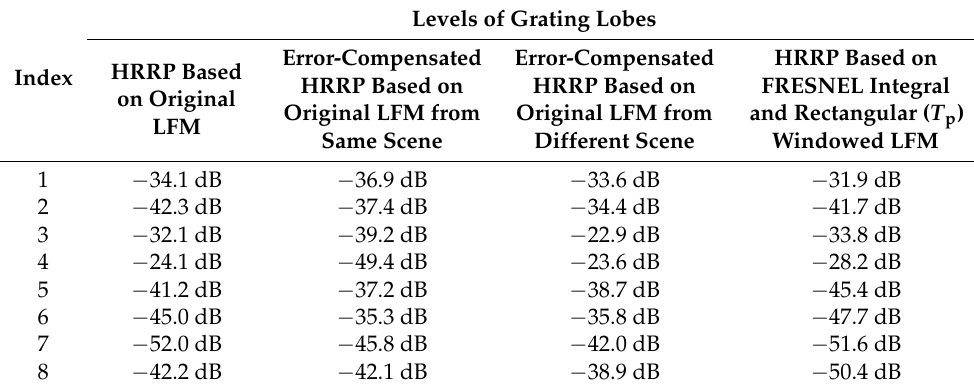
Table 4. Levels of grating lobes of the HRRPs in Figure